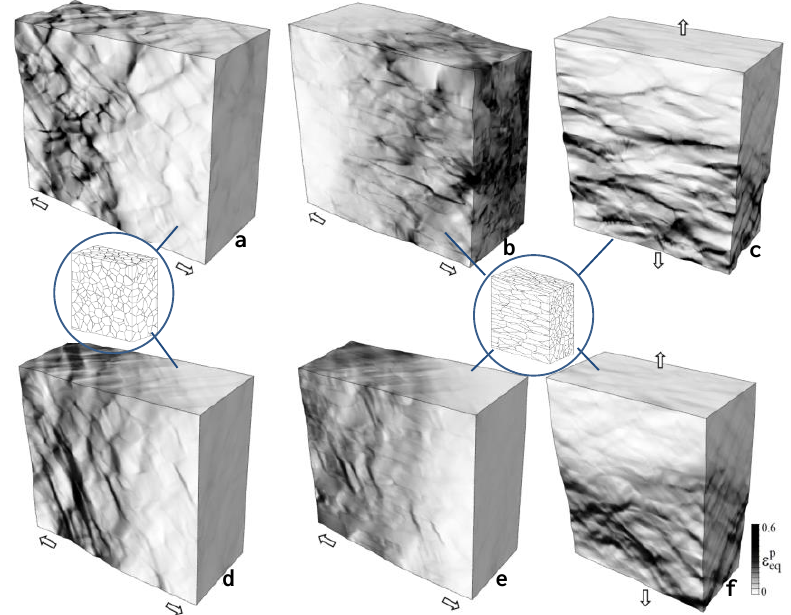
Fig. 2. Equivalent plastic strain fields in model polycrystals with equiaxed and elongated grains: (a-c) no texture, (d-f) moderate cube texture;